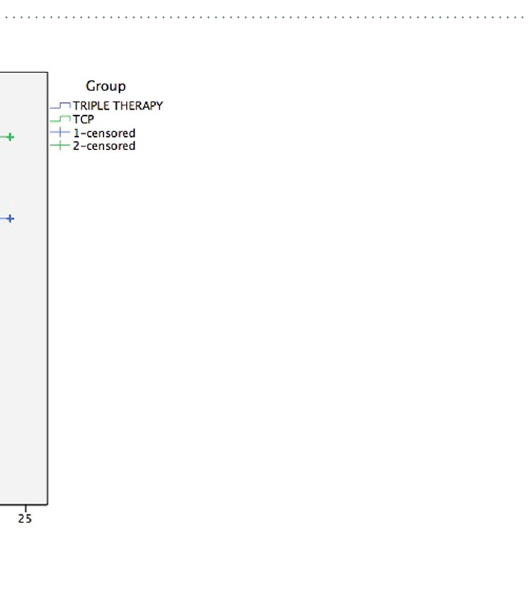
Figure 3. The fundus of the same patient after triple sequential therapy. Corneal oedema regressed after treatment. The retinal condition and laser spot could be seen after